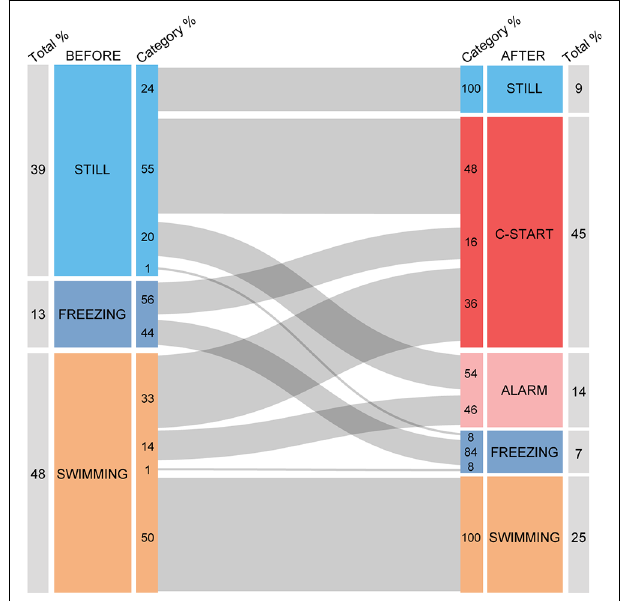
FIGURE 2 | Alluvial diagram of motor behavior before and after looming stimulation. The diagram shows the motor animal’s motor state before (left) and after (right) looming stimulation. Numbers next to the outer edge of the boxes indicate the proportion of animals in each category. Numbers next to the inner edge of the boxes indicate the proportion of animals within each category transitioning from one type of behavior to another. Behavior after stimulation is significantly dependent on previous motor state ( χ 2 test of homogeneity, p <